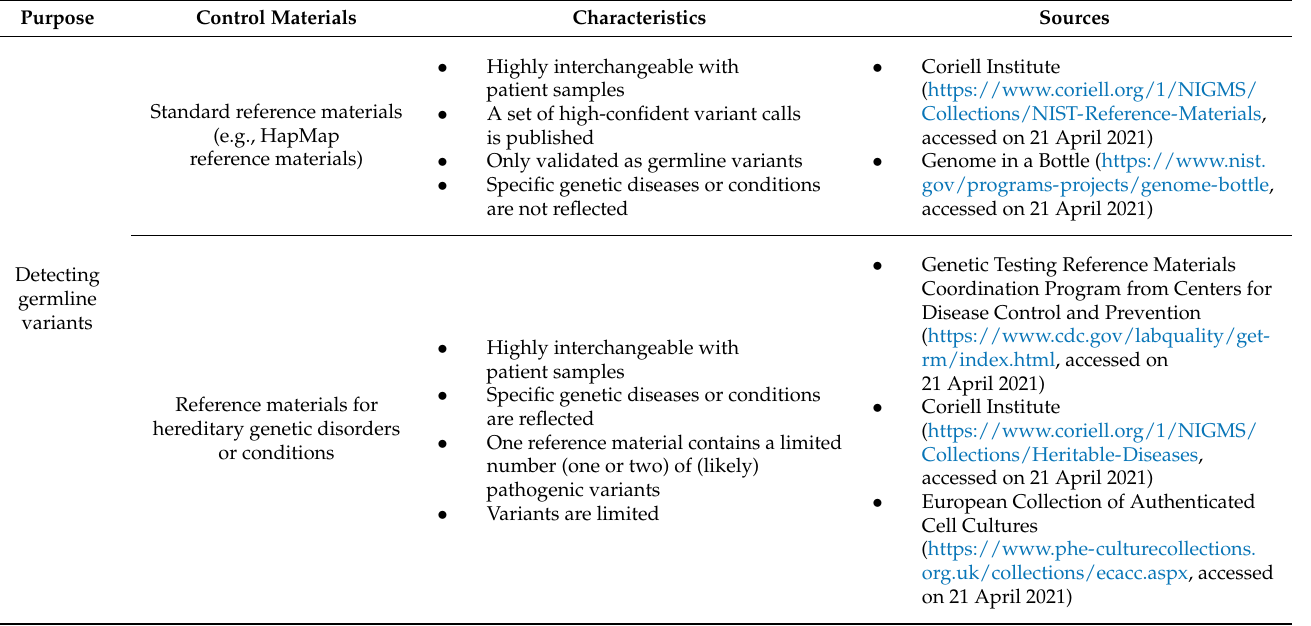
Table 1. Overview of control materials for next-generation